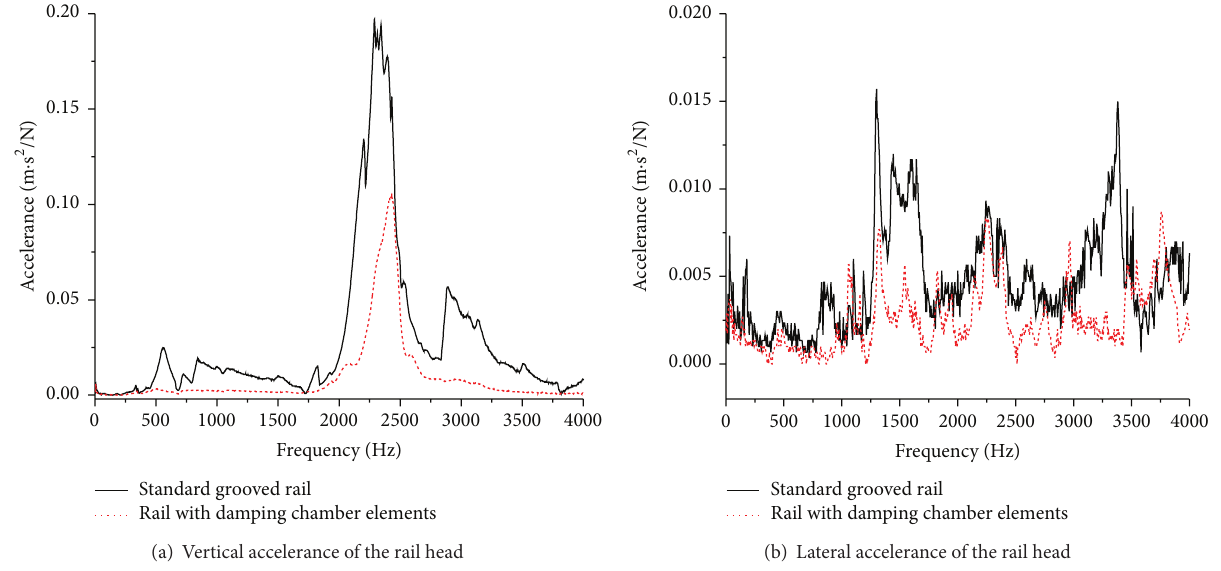
Figure 15: Accelerance of the rail head.